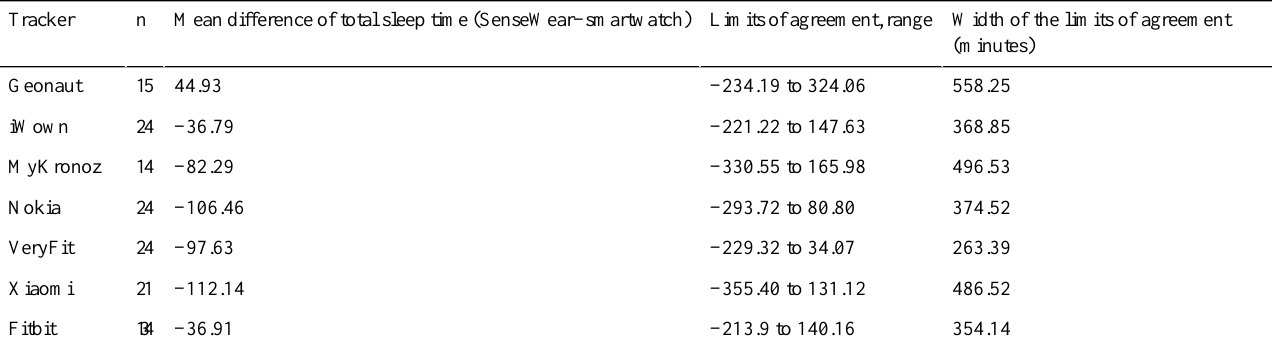
Table 6. Mean differences of total sleep time measures with the SenseWear and limits of agreement of the activity trackers.